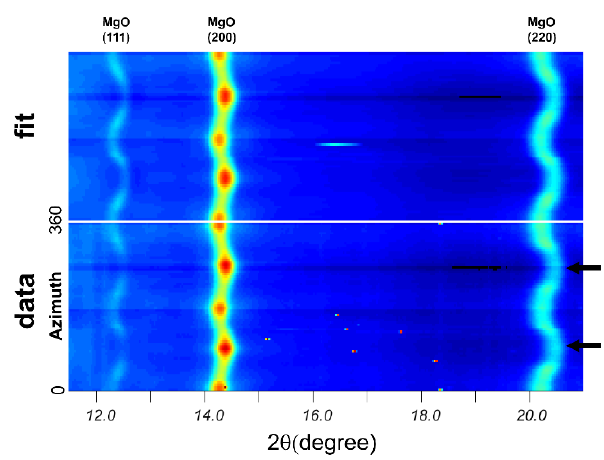
Figure 1. An unrolled diffraction image and MAUD fit of the MgO sample. Black arrow indicates the compression direction. Sinusoidal distortion of diffraction line indicates lattice strain. Systematic intensity variation along azimuth indicates texture.